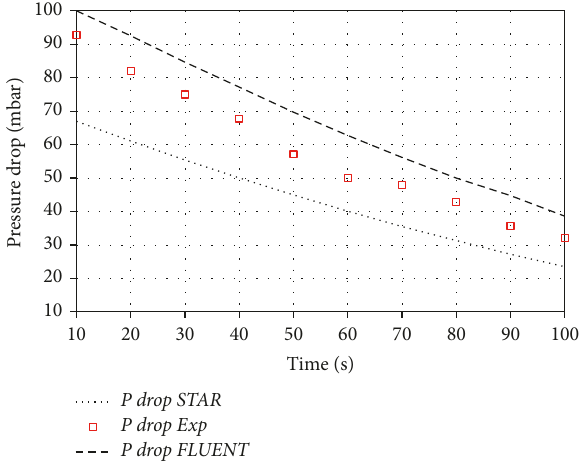
Figure 16: Comparison between pressure drops obtained from experimental data, STAR-CCM+, and FLUENT